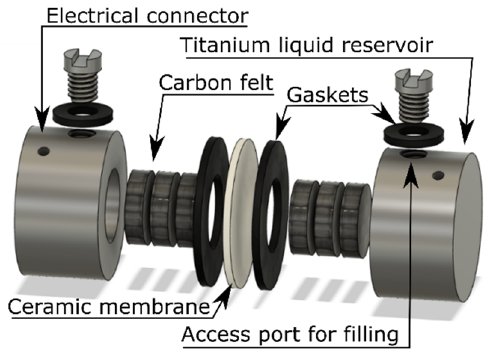
Figure 1. A schematic view of the main cell type used in this